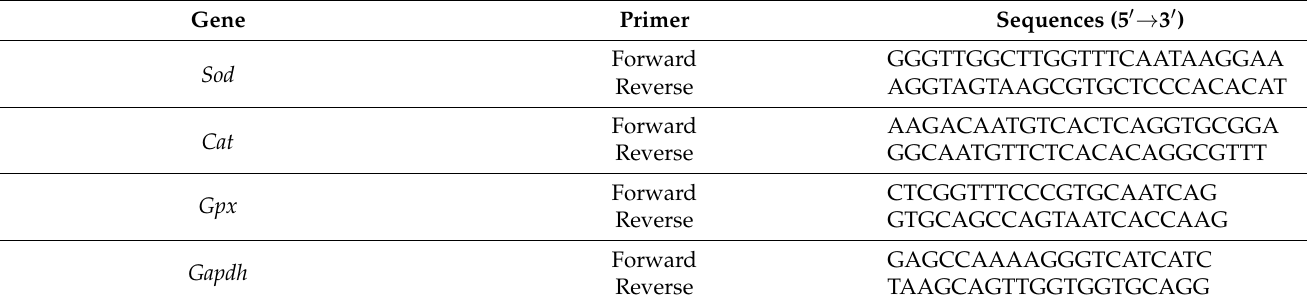
Table 2. Primer sequences for Real-Time Polymerase Chain Reaction RT-PCR. Gene Primer Sequences (5 (cid:48) → 3 (cid:48)